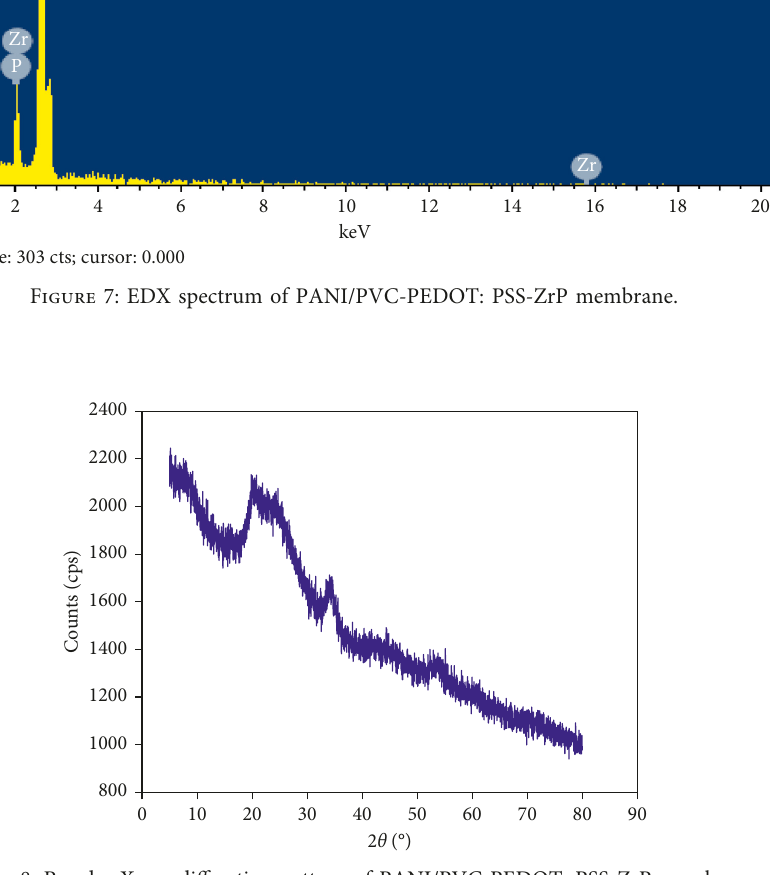
Figure 8: Powder X-ray diffraction pattern of PANI/PVC-PEDOT: PSS-ZrP membrane.